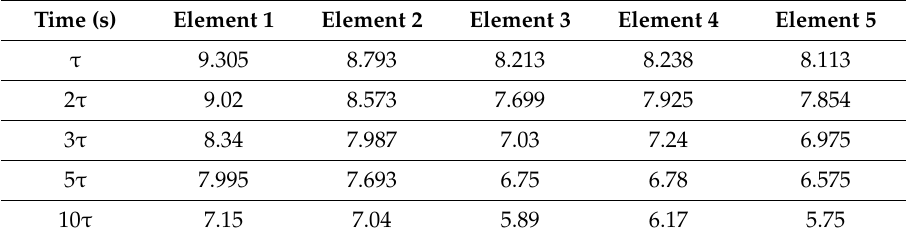
Table 1. The sensing elements output voltage.